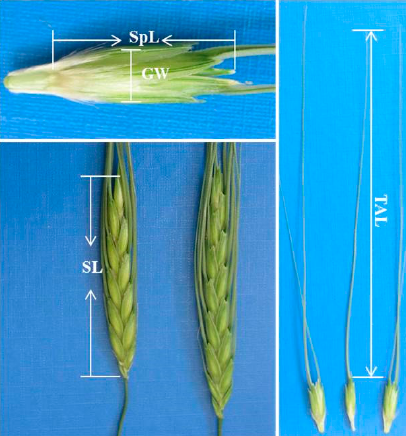
Figure 1. Morphology of T. dicoccoides spike. Measured positions are shown for SpL, GW, SL, and